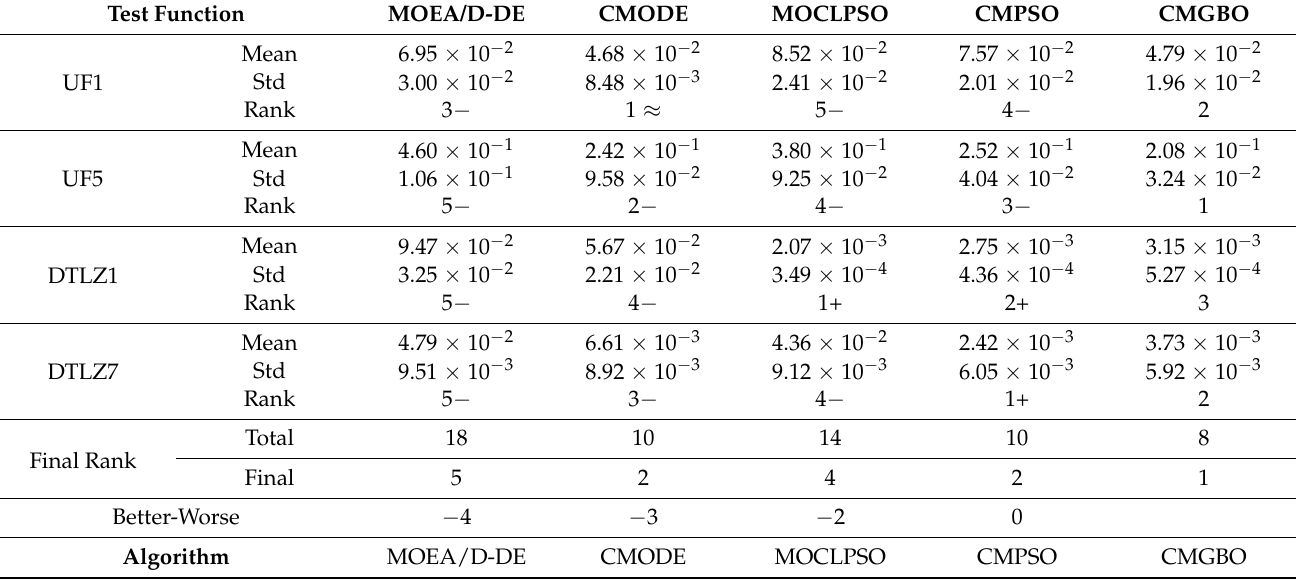
Table 4. Consequences on UF and DTLZ problems.